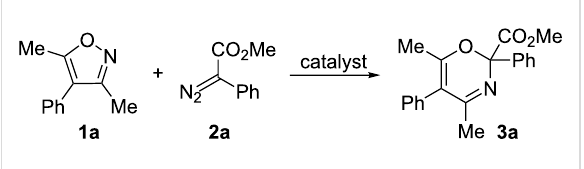
substituted isoxazoles are much more stable than the corres- ponding oxazines E . Therefore, one can expect the formation of only 1-oxa-5-azahexa-1,3,5-trienes when reacting diazo com- pounds with